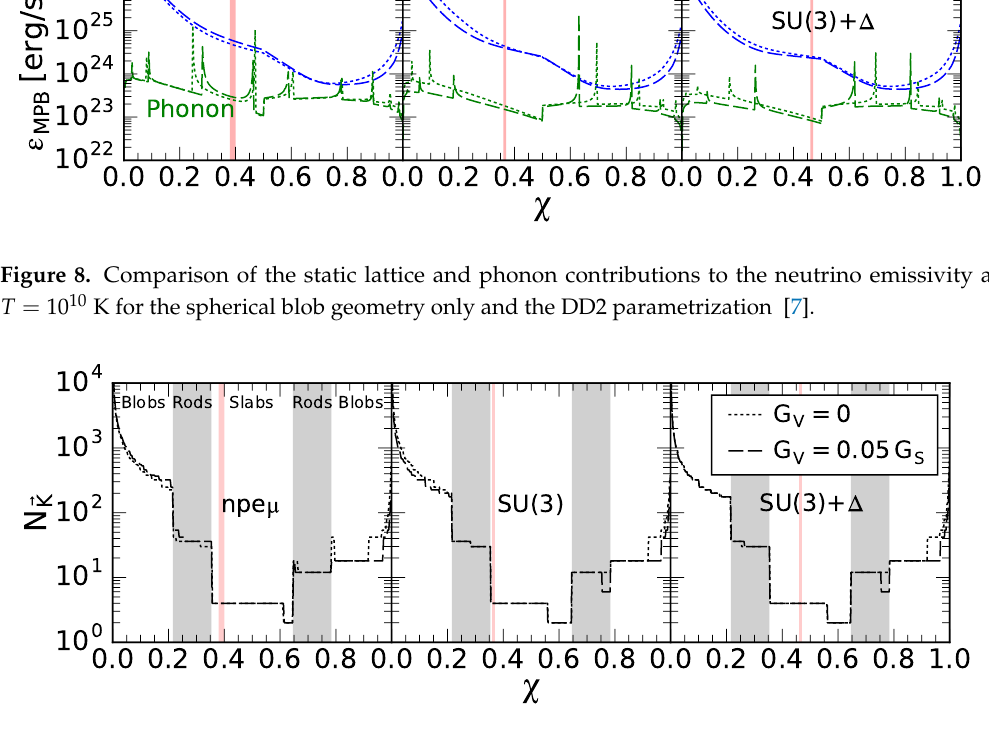
Figure 9. The number of scattering vectors that satisfy the condition K < 2 k e as a function of the quark fraction [7] (see Figure 2 for additional details). Similar figures for the SWL, GM1L, and ME2 parametrizations can be found in